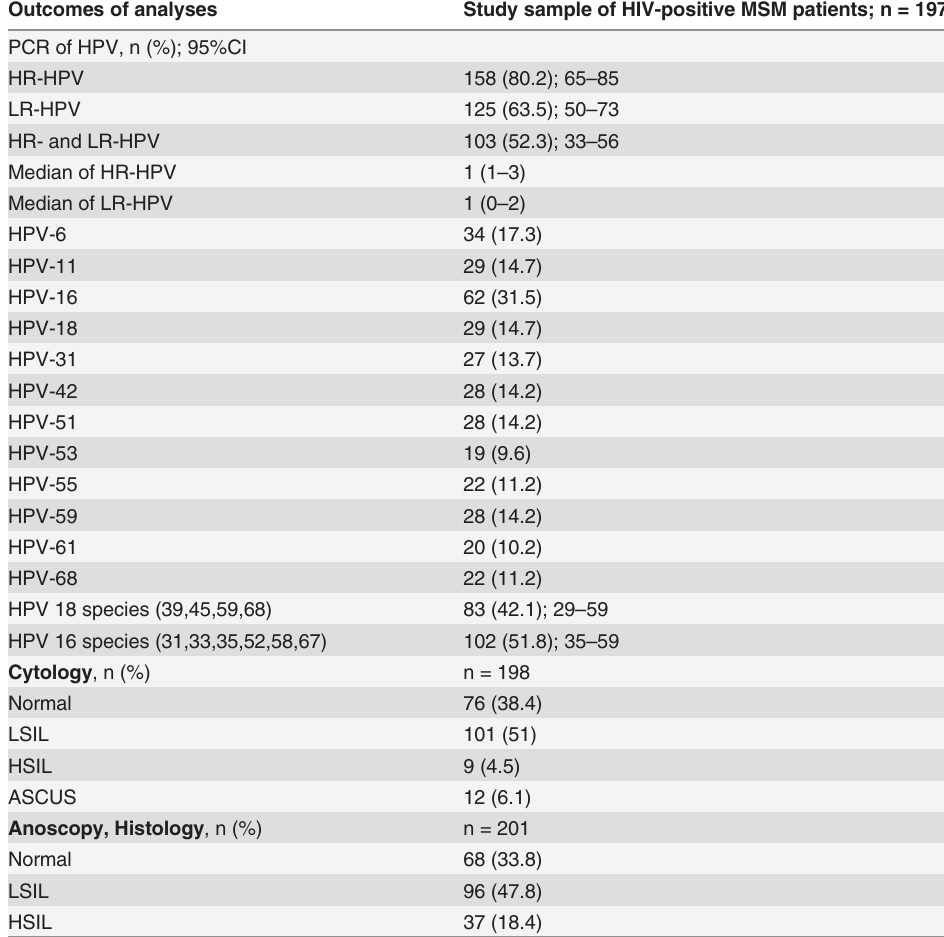
Table 2. Outcomes of PCR of HPV, cytology and histology. Outcomes of